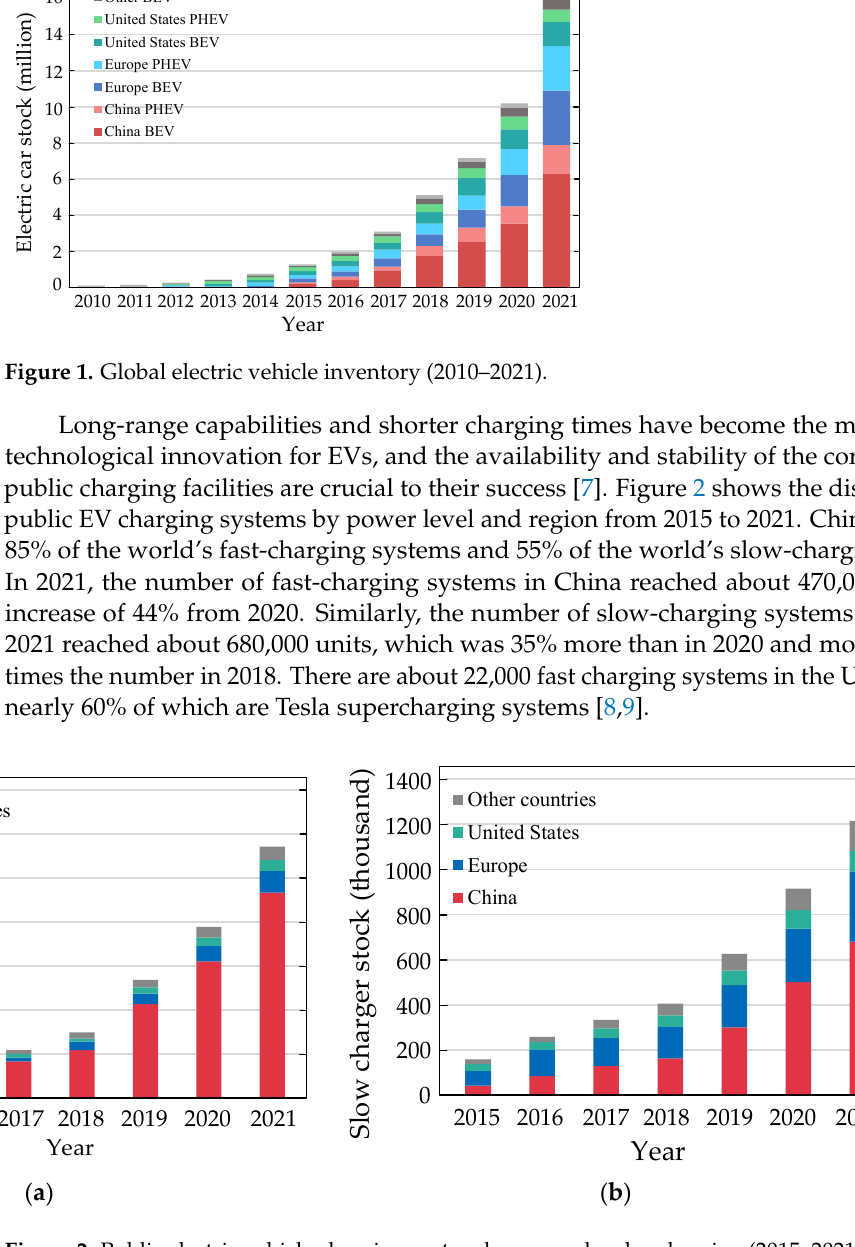
Figure 1. Global electric vehicle inventory (2010–2021).